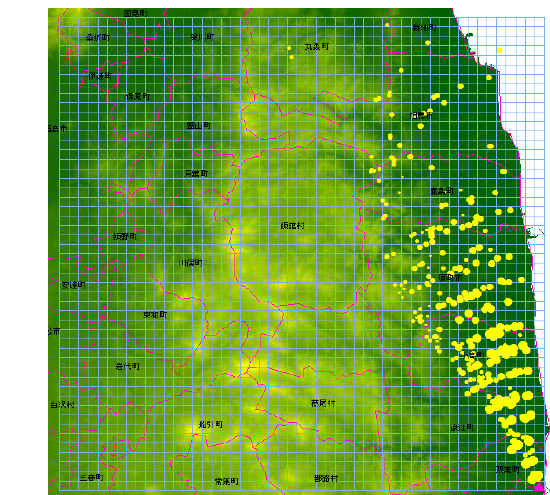
Figure 10. Particle trajectory estimated from wind directions and velocities on March 18